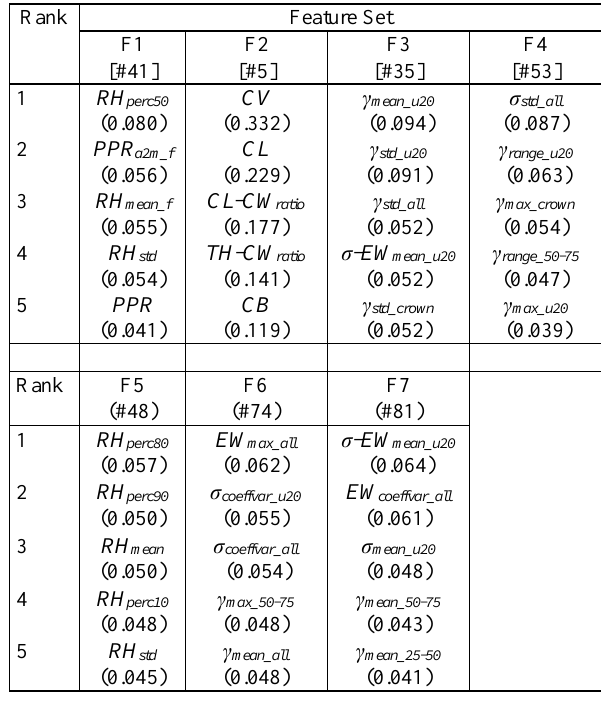
Table 6. Feature importance for the given feature sets at tree family level. The top five features are ranked by the Gini Coefficient. The total number of features (#) and the Gini coefficient of the single features is given in